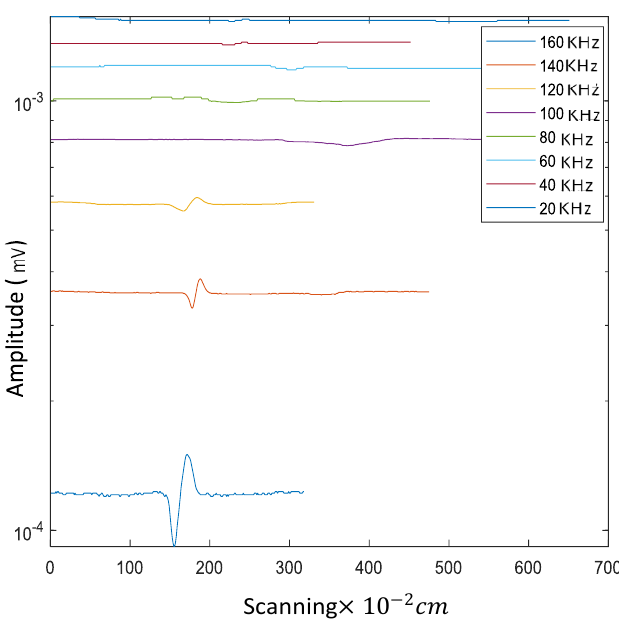
FIGURE 12 Results of the frequency scanning experiment for the Eddy current testing system with giant magnetoresistance sensor.